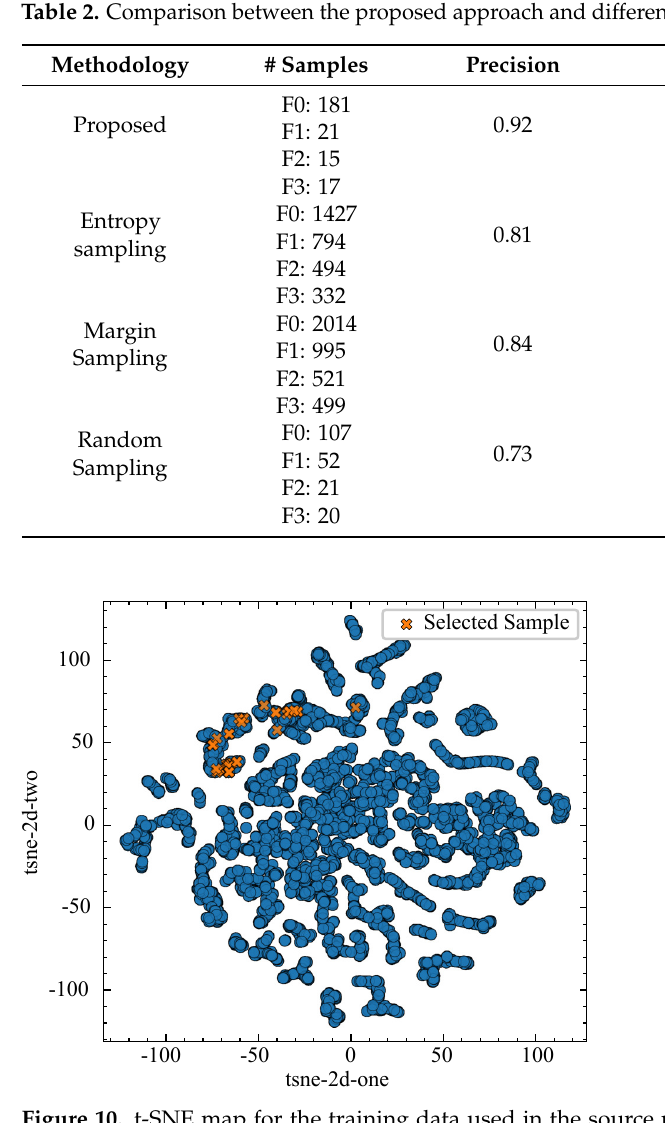
Figure 10. t-SNE map for the training data used in the source modelling and the target samples selected with the uncertainty sampling methods. The samples marked with an ”x” correspond to target samples selected that are not correctly predicted after the model